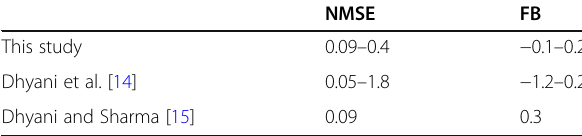
Table 4 Performance evaluation of CALINE4